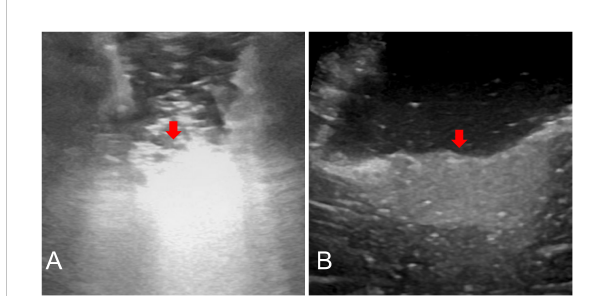
FIGURE 5 Postoperative US: Surgical cavity was covered by the hemostatic gauze ( A , red arrow). Fully hemostatic, taking out all hemostatic materials and normal saline fi lls the surgical cavity, and the residual tumor can be seen ( B , red